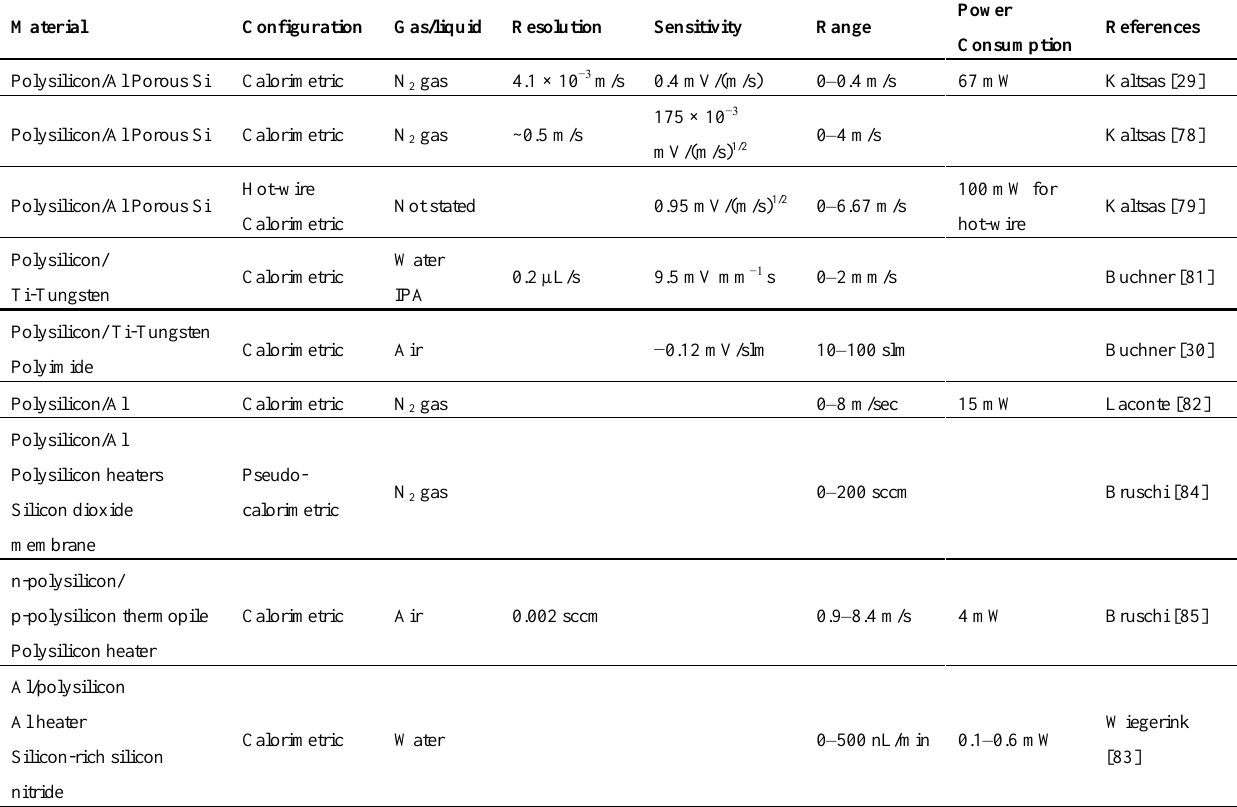
Table 4. Thermoelectric flow sensor feature